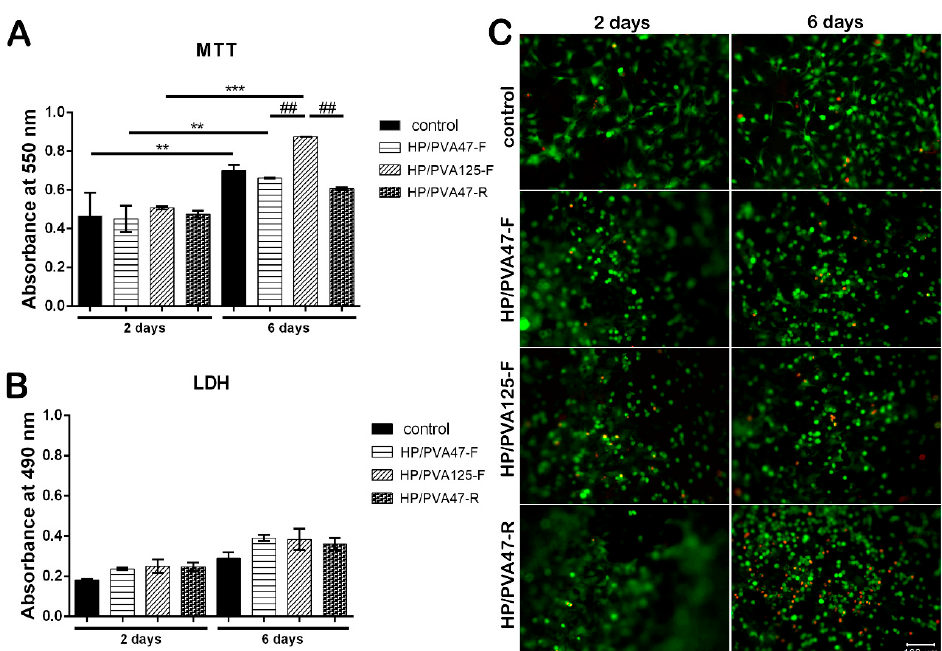
Figure 6. Quantitative evaluation of cell viability and proliferation after 2 and 6 days of culture, using MTT assay ( A ); Quantitative evaluation of the material’s cytotoxicity after 2 and 6 days of culture, using LDH assay ( B ); Confocal microscopy displaying live (green) and dead (red) cells after 2 and 6 days of culture ( C ); scale bar 100 µm.